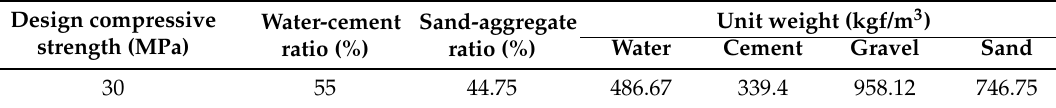
Figure 4. Comparison of mean values: ( a ) tensile strength; ( b ) compressive strength; ( c ) shear strength by tensile loading; ( d ) bond strength; and ( e ) bond strength by slant shear. Table 6. Concrete mix proportion.